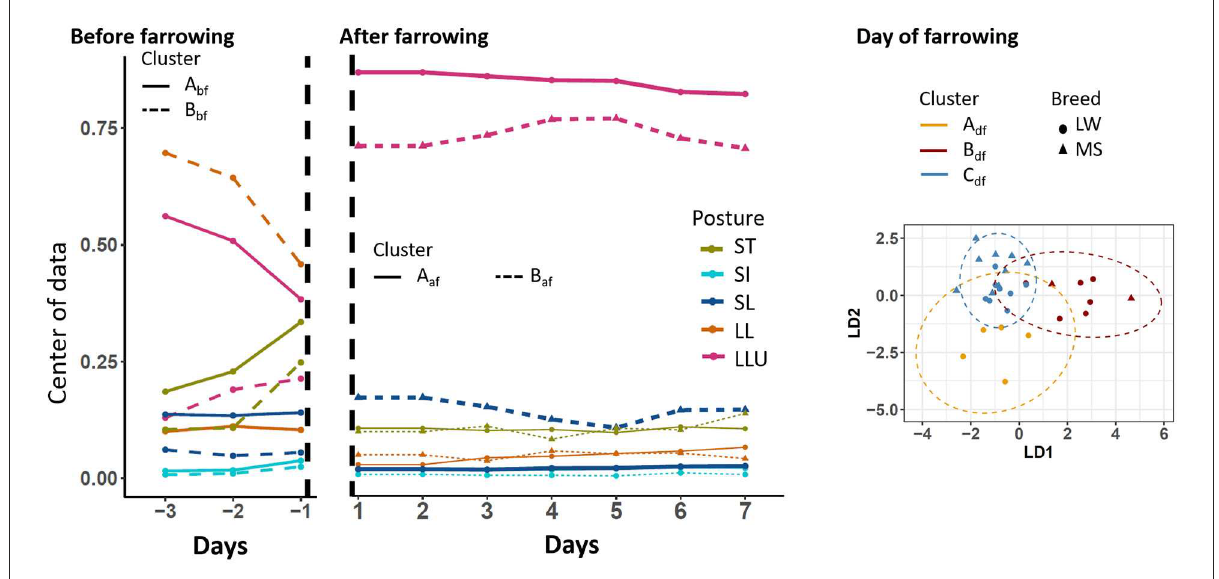
FIGURE3 Longitudinal changes in sow postural activity according to the clusters that were identified before, after, and on the day of farrowing. SI, sitting; LL, lateral lying; SL, sternal lying; LLU, lateral lying udder exposed; ST, standing; LW, Large-White; MS, Meishan. The centers of data are shown in the periods before and after farrowing because longitudinal analyses were applied. The two first components of the linear discriminant analysis are shown on the day of farrowing.